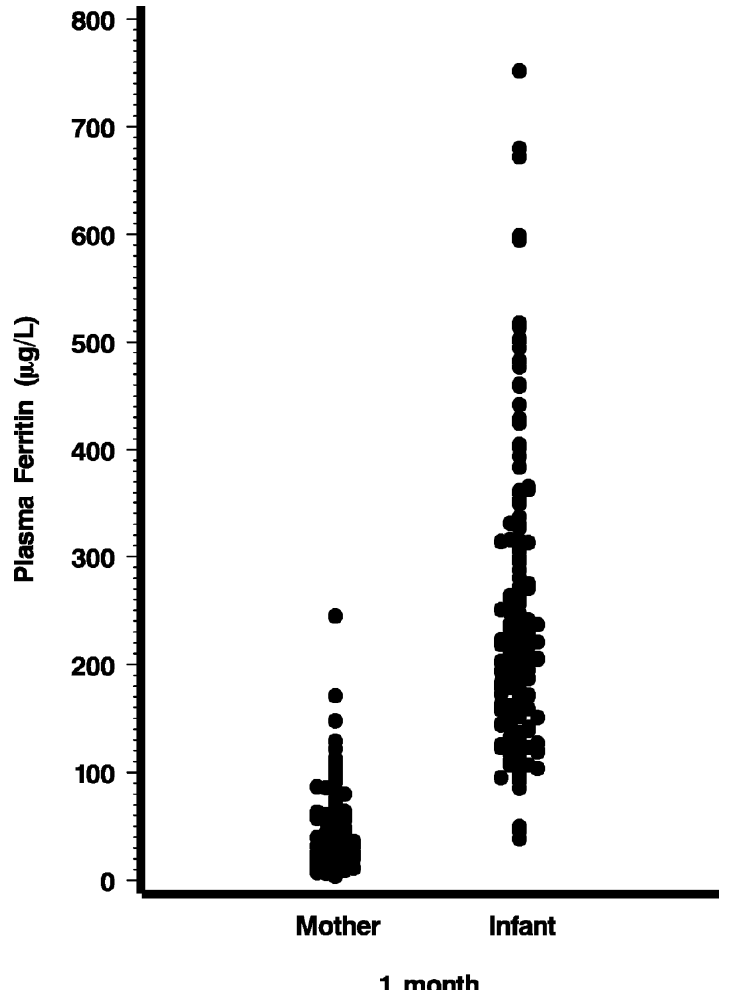
Figure 1. Plasma ferritin concentrations of mothers and infants one month after